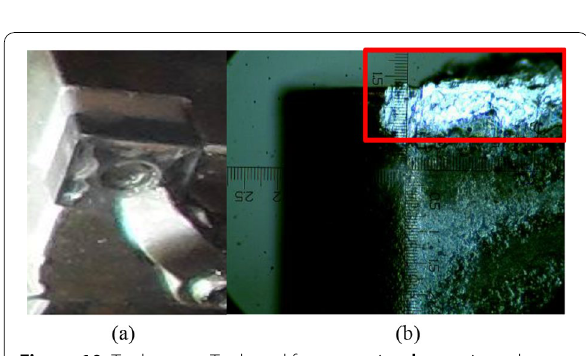
Figure 10 Tool wear: a Tool used for processing, b wear in tool